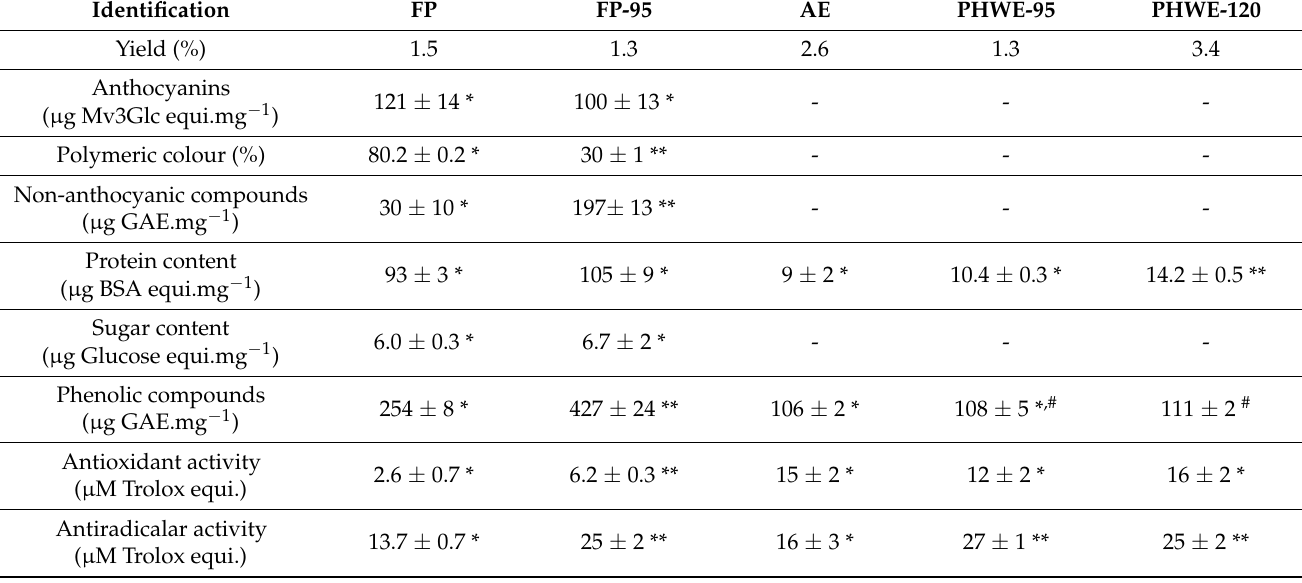
Table 1. Chemical composition and antioxidant activity of free polyphenols and polysaccharide–polyphenol conjugates recovered from red grape pomace by solid–liquid extraction and pressurized hot water extraction. Results are presented as mean value ± standard deviation. For free polyphenols fractions or polysaccharide–polyphenol conjugates fractions, columns with the same symbol do not present statistical differences ( p >